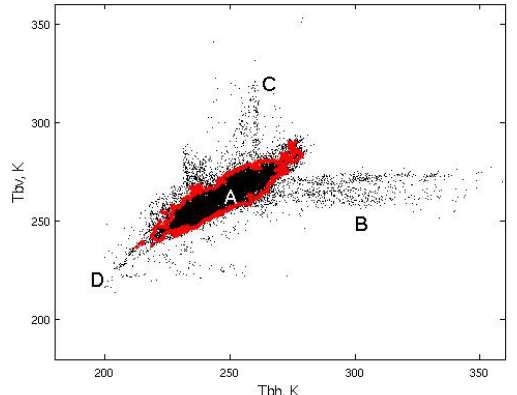
Fig. 3. Side-looking antenna TbV vs. TbH for the six CAROLS flights in 2009. The measurements outside of the red contour were removed from the analysis. The A–D letters correspond to data clusters in the TbH–TbV space. The main cluster A (except for TbH < 220K) corresponds to the data analyzed in Sects. 3–4. Clus- ters B–D correspond to observations excluded from the dataset: B and C are related to unmitigated RFI perturbations close to ur- ban areas; D is related to a high density of water